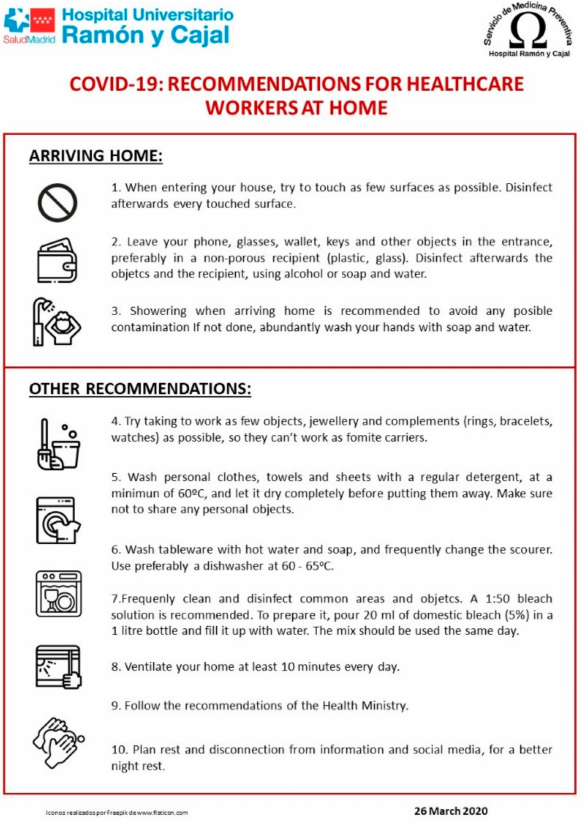
Figure 3. Recommendations for health